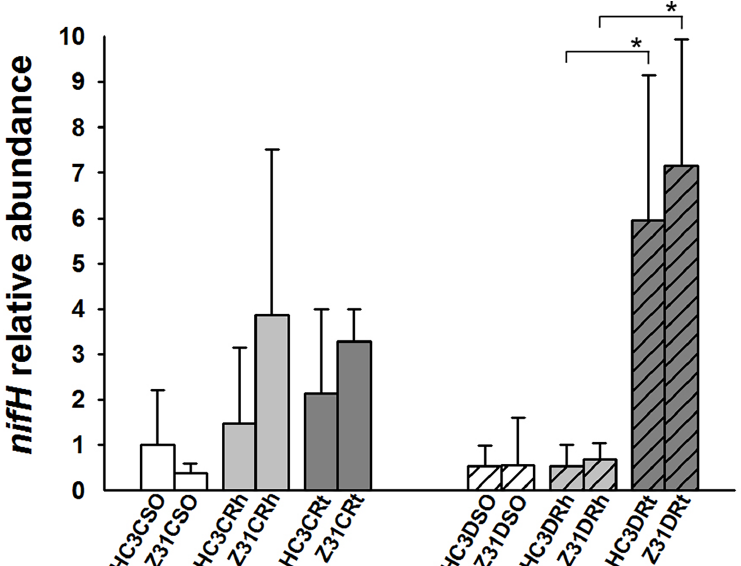
Fig 7. Relative abundance of the nifH gene in soybean root-associated bacterial communities of Z31 and HC3 at the flowering and seed-filling stages. CRt and DRt represent the roots of soybean at the flowering and seed-filling stages, respectively. CRh and DRh represent the rhizospheric soils of soybean at the flowering and seed-filling stages, respectively. CSO and DSO represent the surrounding soils of soybean at the flowering and seed-filling stages, respectively. Levels of the nifH gene abundance were normalized to 16S rDNA abundance. A value of 1 was assigned to the detected value of the surrounding soil of HC3 at the flowering stage (HC3CSO). The error bars represent the standard deviation of four or six replicates of soil or root samples and each replicate with technical triplicate. (cid:3) Indicates significant difference ( P < 0.05) according to the one-way ANOVA.